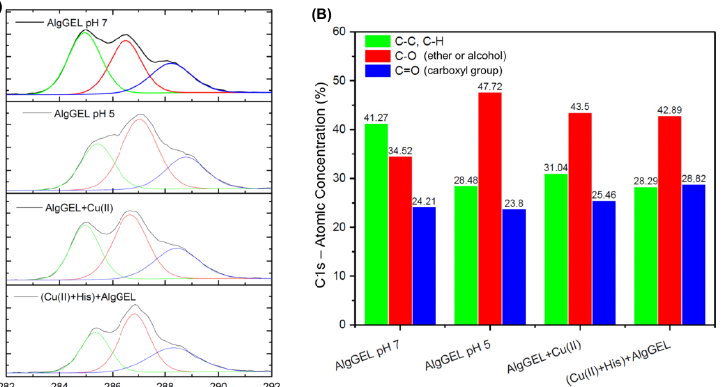
Figure 4. ( A ) High-resolution XPS spectra for carbon (C1s) and its respective deconvolutions for AlgGel before and after copper adsorption. The pH values represent the solution conditions for bead storage after crosslinking. ( B ) Deconvoluted peaks for C1s binding energies and their respective atomic concentration in each studied system. Molecules 2022 , 27 , x FOR PEER REVIEW